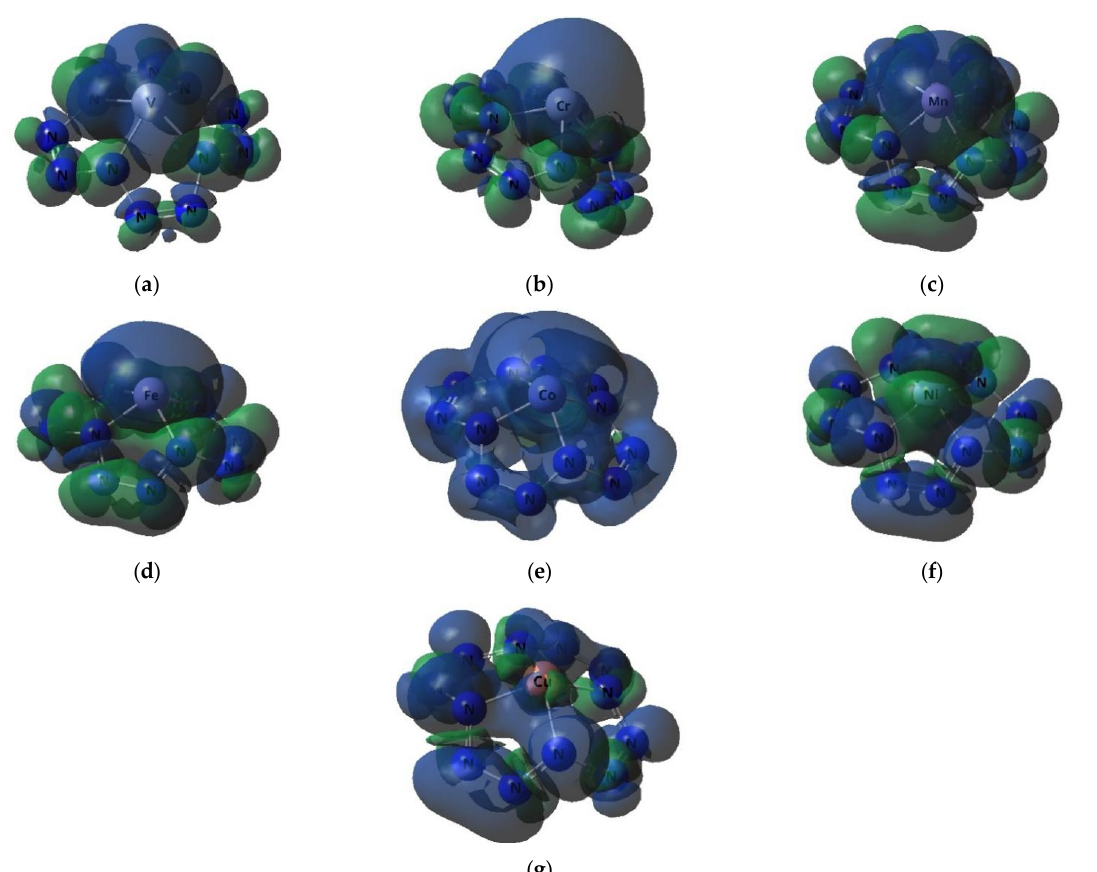
Figure 5. The images of spin density distribution in M(N 12 ) complexes obtained by DFT M06/TZVP method: ( a ) V(N 12 ), ( b ) Cr(N 12 ), ( c ) Mn(N 12 ), ( d ) Fe(N 12 ), ( e ) Co(N 12 ), ( f ) Ni(N 12 ), ( g ) Cu(N 12 ). Table 4. Standard thermodynamic parameters of formation ( H 0 f ,298 , S 0 f ,298 and G 0 f ,298 ) for various M(N 12 ) calculated by DFT M06/TZVP method.